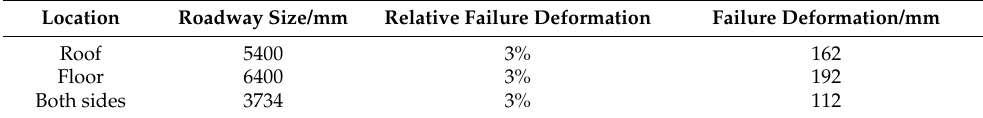
Table 5. Deformation of roadway failure.